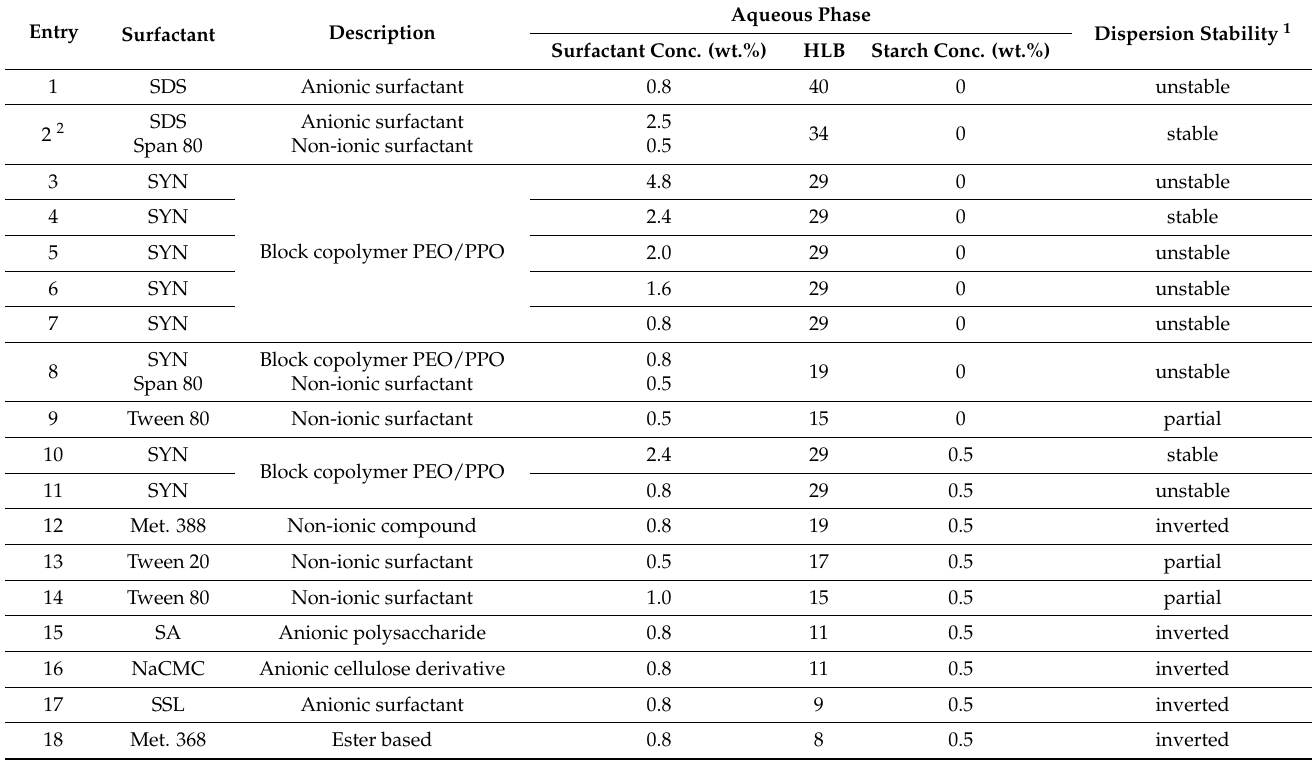
Table 3. Screening of different surfactants for the preparation of PLA